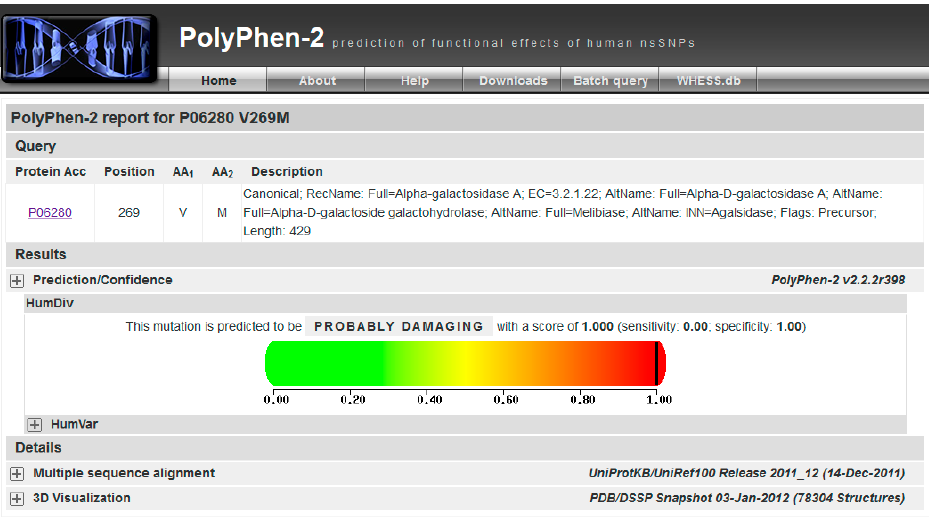
Figure 3. PolyPhen-2 graphical output.